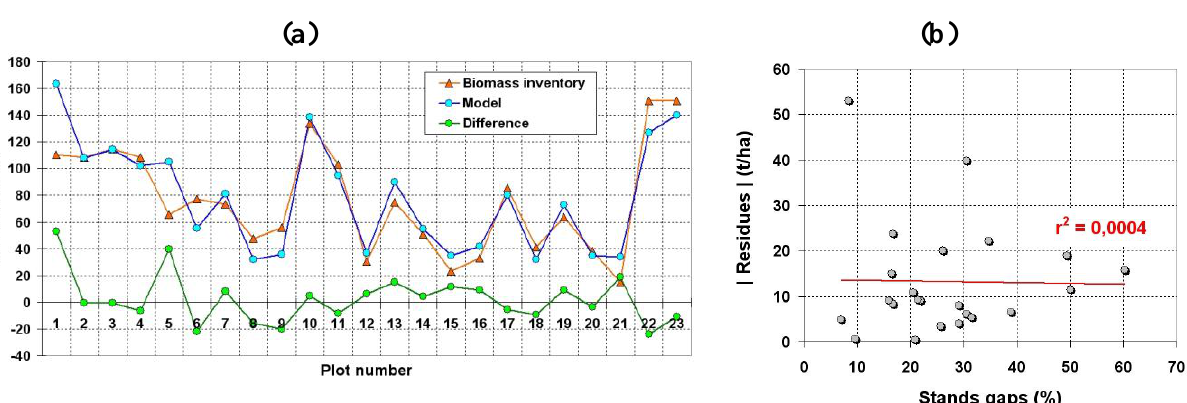
Figure 13. (a) Comparative graph of inventoried biomass, modeled biomass, and the correspondent difference; (b) Graph of stand gaps percentage and model regression